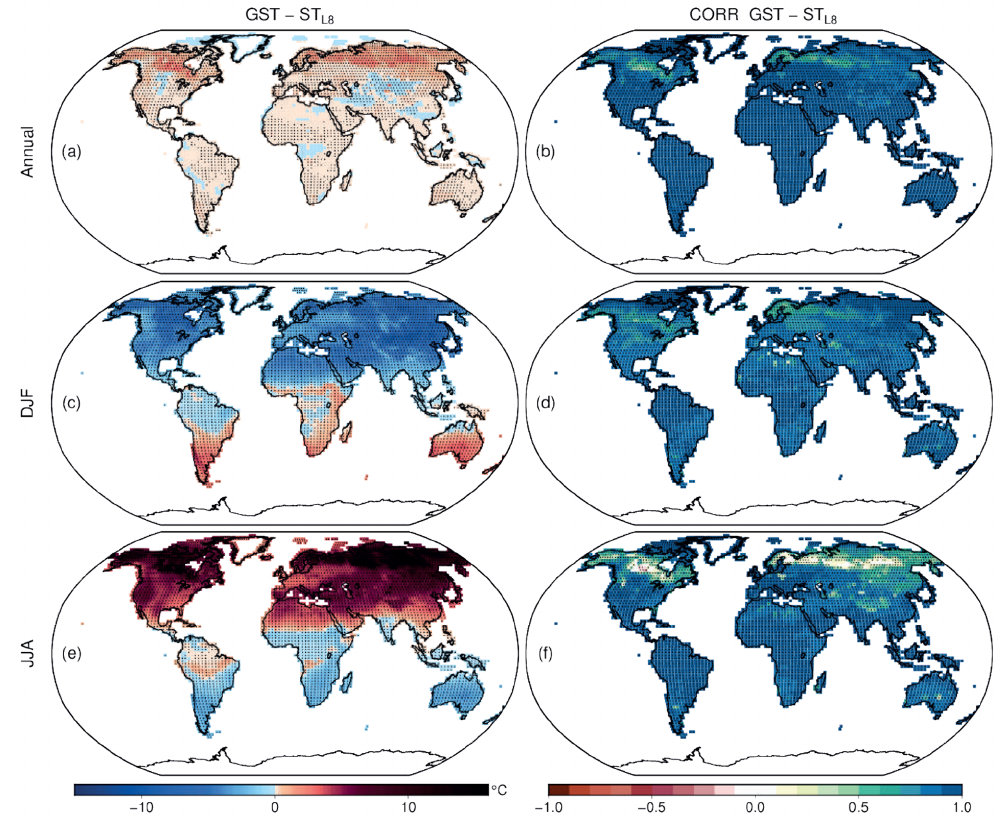
Figure 6. (a) Annual, (c) DJF and (e) JJA spatial distribution of GST minus ST L8 differences during the 850-2005CE period. (b) Annual, (d) DJF and (f) JJA spatial distribution of the correlation coefficients between GST and ST L8 for the same period. Black dots indicate that 80% of the members within the ALL- F ensemble deliver statistical significance ( p < 0 .